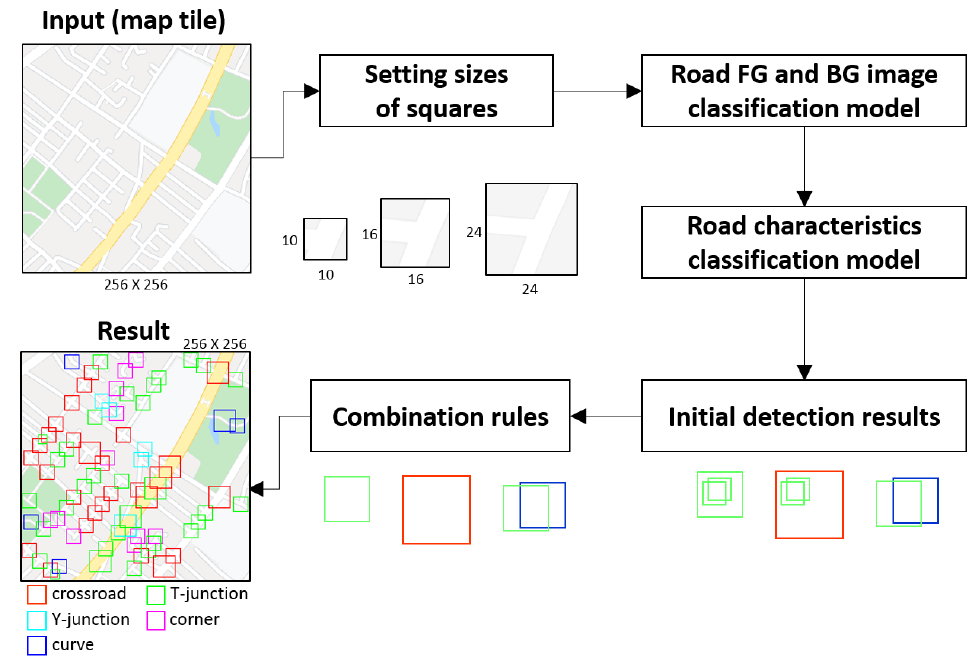
Figure 1. Workflow of the road characteristics detection.